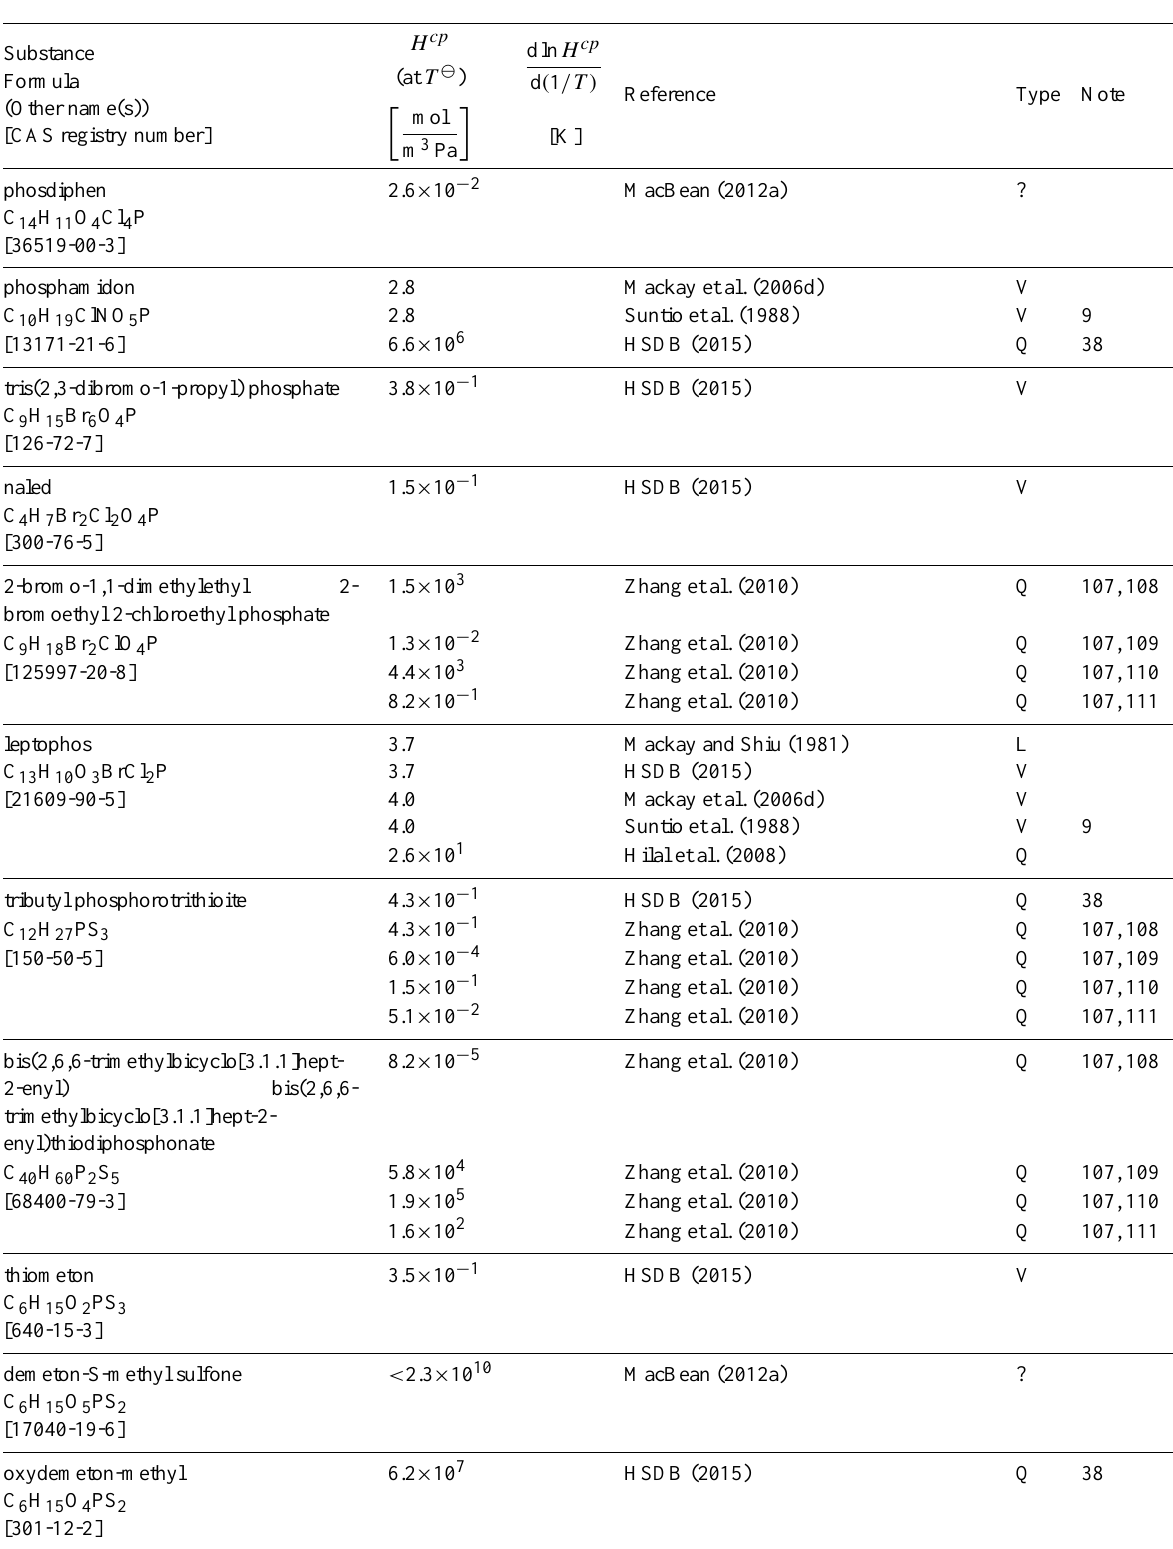
Table 6: Henry’s law constants for water as solvent